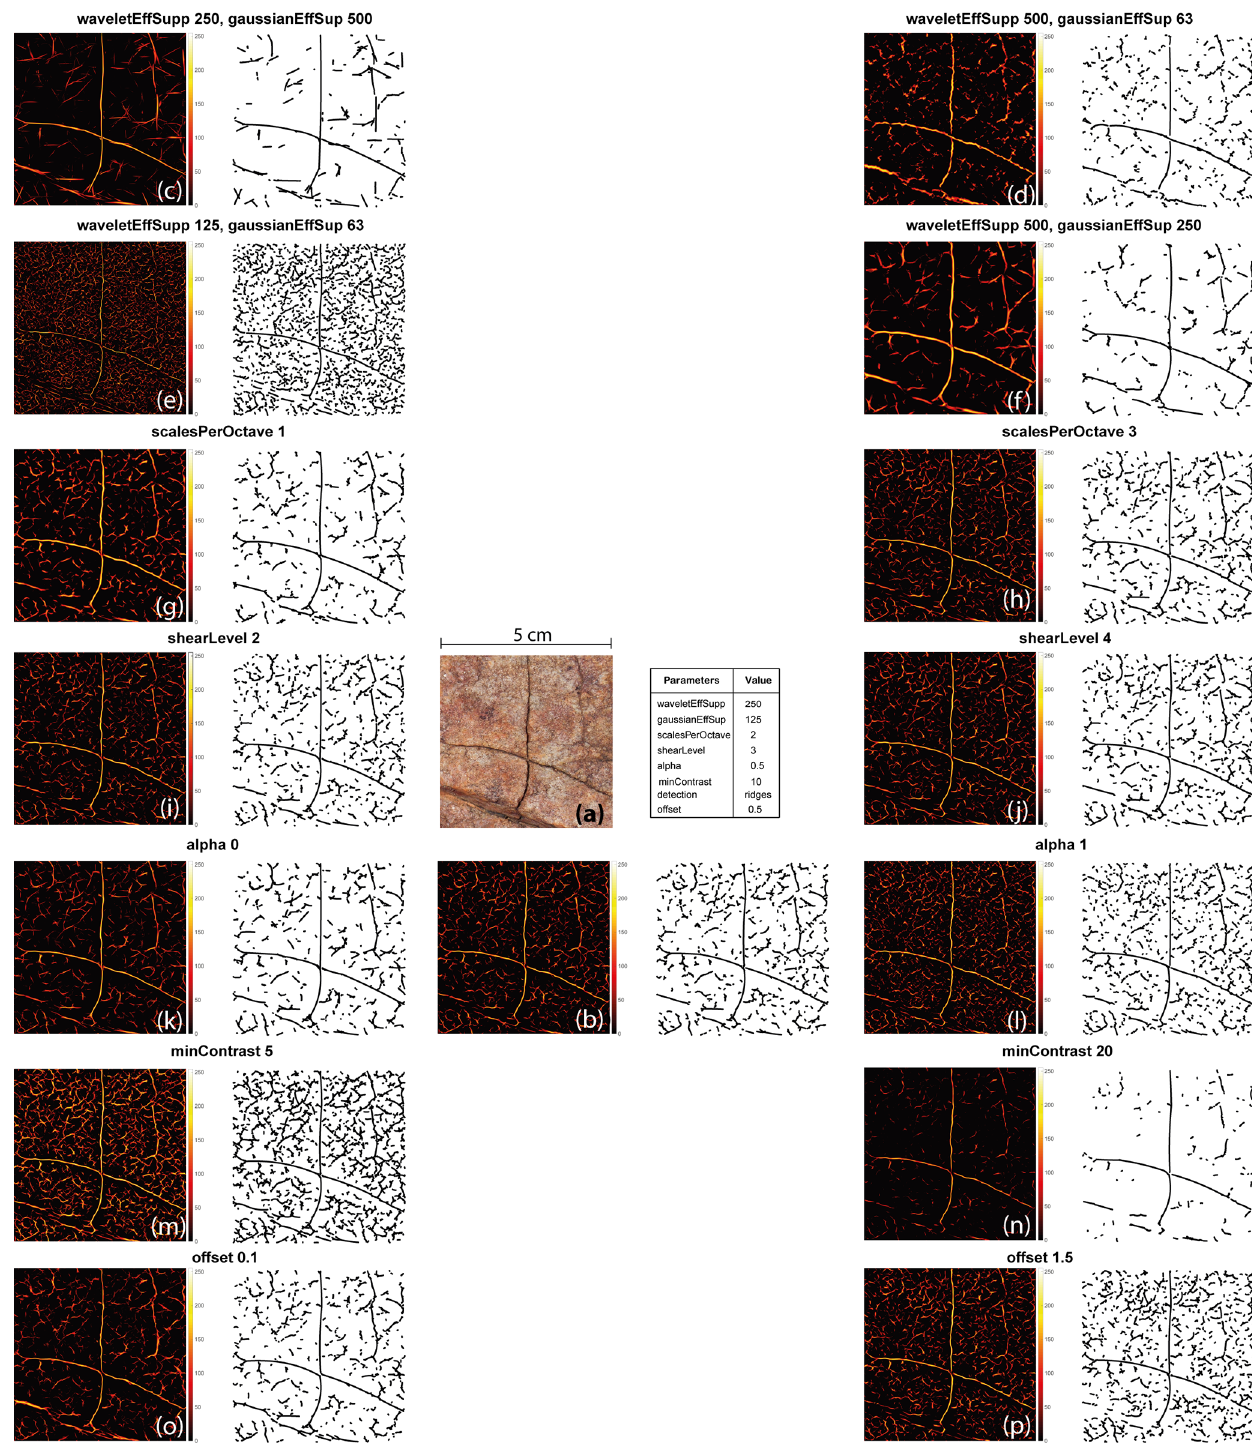
Figure 3. Effects of variation in ridge parameters on extracted ridges and the corresponding vectorizations using a fractured siliciclastic example. A constant greyscale threshold is applied to the ridge map and all other parameters with respect to post-processing are kept constant. (a) Fractured rock image (5cm × 5cm) and tabulated base case parameters. (b) Ridge maps and vectorized traces for base case. (c) Effect of a higher Gaussian effect support compared to wavelet support. (d) Effect of a large difference in wavelet effective support with respect to Gaussian support. (e–o) Lower bounds of parameters with respect to base case, corresponding ridge maps and traces. (f–p) Upper bounds of parameters with respect to base case, corresponding ridge maps, and